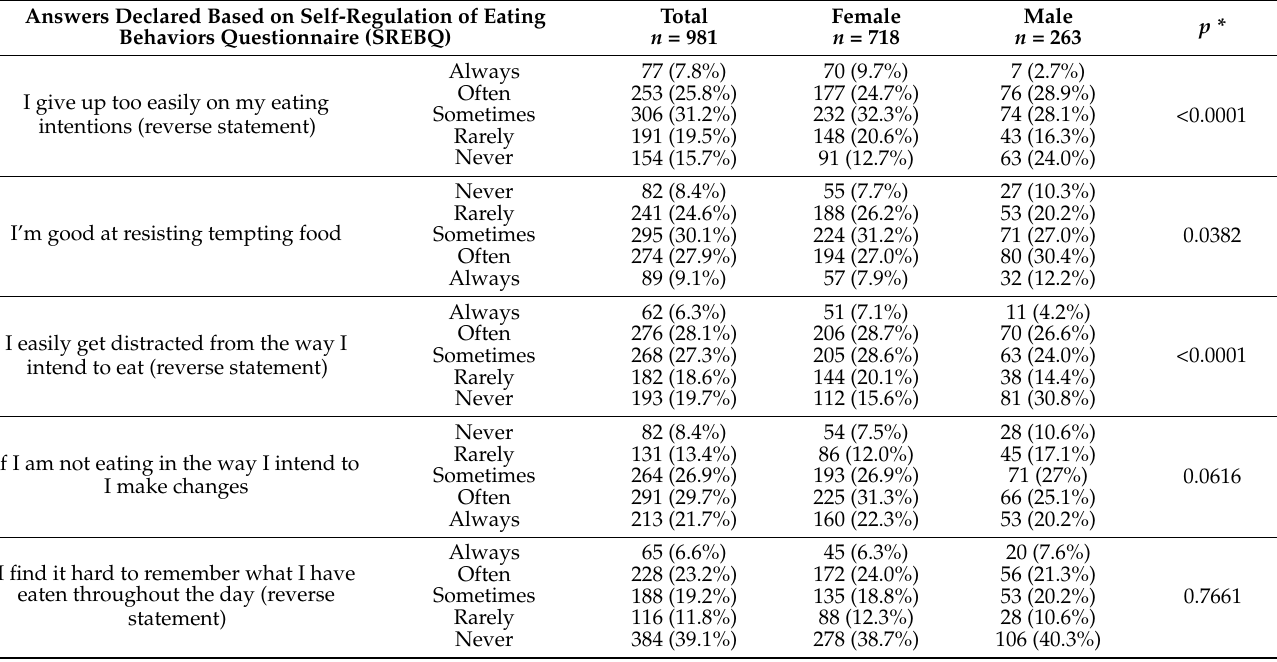
Table 3. The self-regulation of eating behaviors assessed using the Self-Regulation of Eating Behaviour Questionnaire (SREBQ), within the Polish Adolescents’ COVID-19 Experience (PLACE-19) Study ( n = 981) and in subsamples stratified by gender.